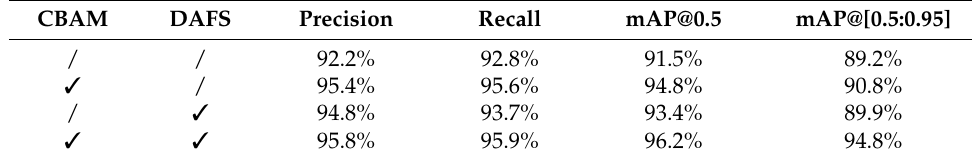
Table 1. YOLOv5s ablation experiment.